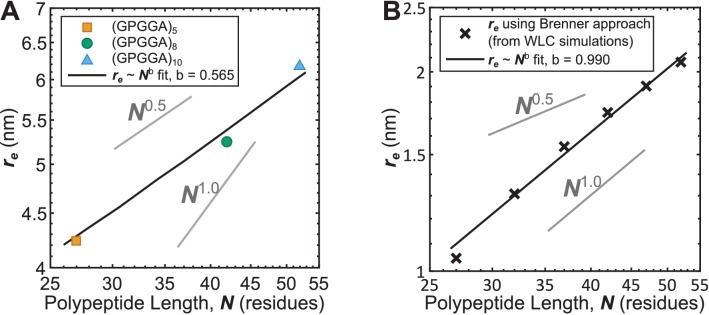
Experimental and theoretical examinations of other models (Brenner et al., 2016) of (GPGGA)n mechanical sensitivity.(A) Measured relationship between average polypeptide end-to-end distance re as a function of the number of residues in the (GPGGA)n extensible domain N shows re~N1/2 behavior characteristic of unstructured polypeptides; data transformed from Figure 2A using the proposed model of TSMod mechanical sensitivity. (B) After simulating unstructured polypeptides of various lengths in the context of the WLC model, calculation of re using the approach put forth by (Brenner et al., 2016) yields an artificial re~N1 behavior. Note that plots are logarithmic on both axis such that power-law relationships appear as straight lines.10.7554/eLife.33927.019Figure 2—figure supplement 6—source data 1.Comparitive analysis of models of flagelliform polypeptide mechanics.